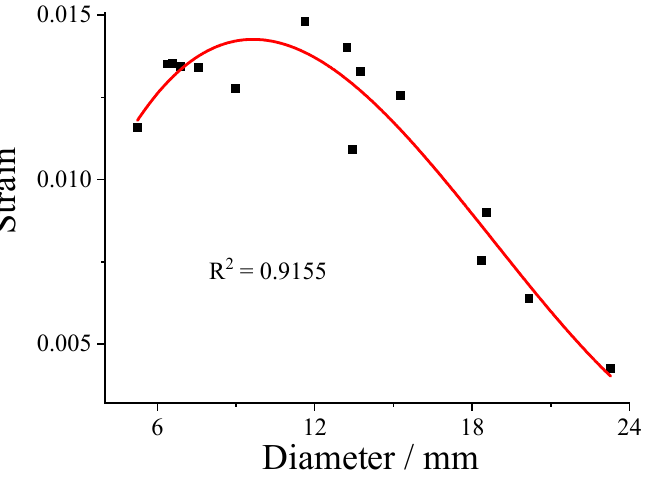
Figure 5. Relationship between Camellia oleifera branch diameter and ultimate strain value. R 2 is the polynomial fitting correlation coefficient.